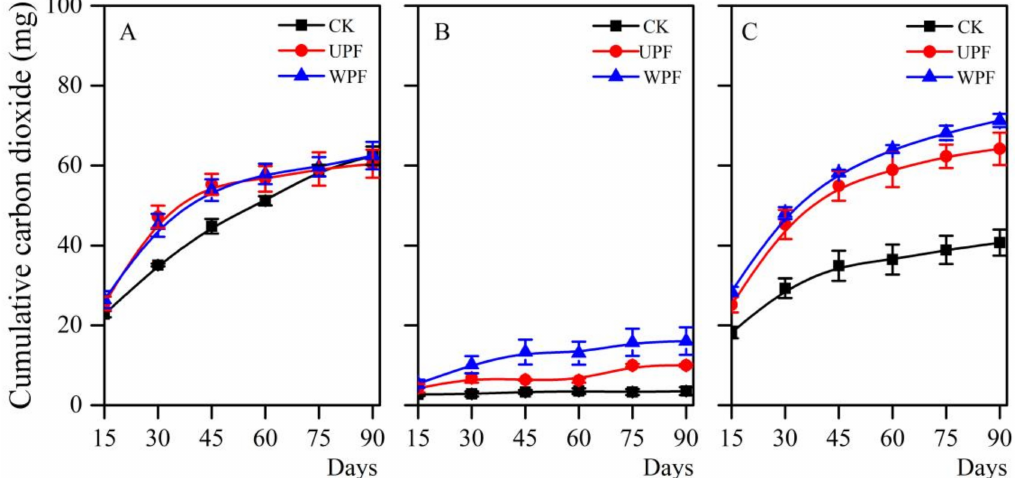
Figure 8. Cumulative CO 2 evolution from polyethylene film incubated with individual bacterial strains and a bacterial consortium, measured at 15-day intervals over 90 days. ( A ) Arthrobacter sp., ( B ) Streptomyces sp., ( C ) Arthrobacter sp. and Streptomyces sp. CK indicates the presence of bacteria without polyethylene film. Data are the mean ± SE (n =